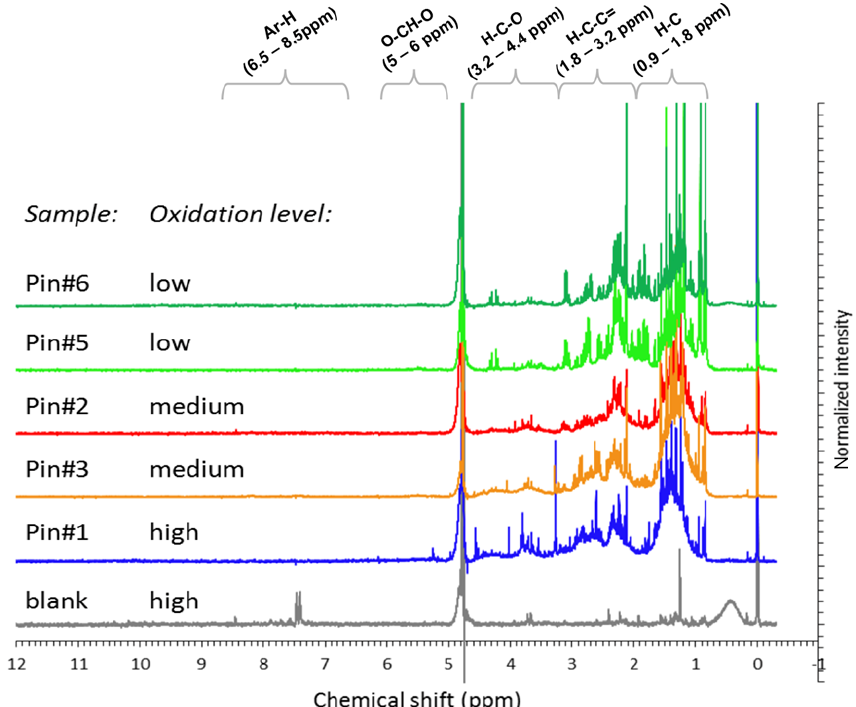
Figure 1. 1 H-NMR spectra of α -pinene SOA as a function of increasing photochemical age in the potential aerosol mass (PAM) oxidation flow reactor. The sharp singlet at 0ppm represents the internal standard (TSP- d 4 ), while the broad peak at 4.8ppm is the – partly instrumen- tally suppressed – hydrogen deuterium oxygen (HDO) peak. The sharp singlets between 0.9 and 2.2ppm in the fresh SOA samples (Pin#5 and Pin#6) are genuine bands of the samples and were identified as methyl groups of pinic and pinonic